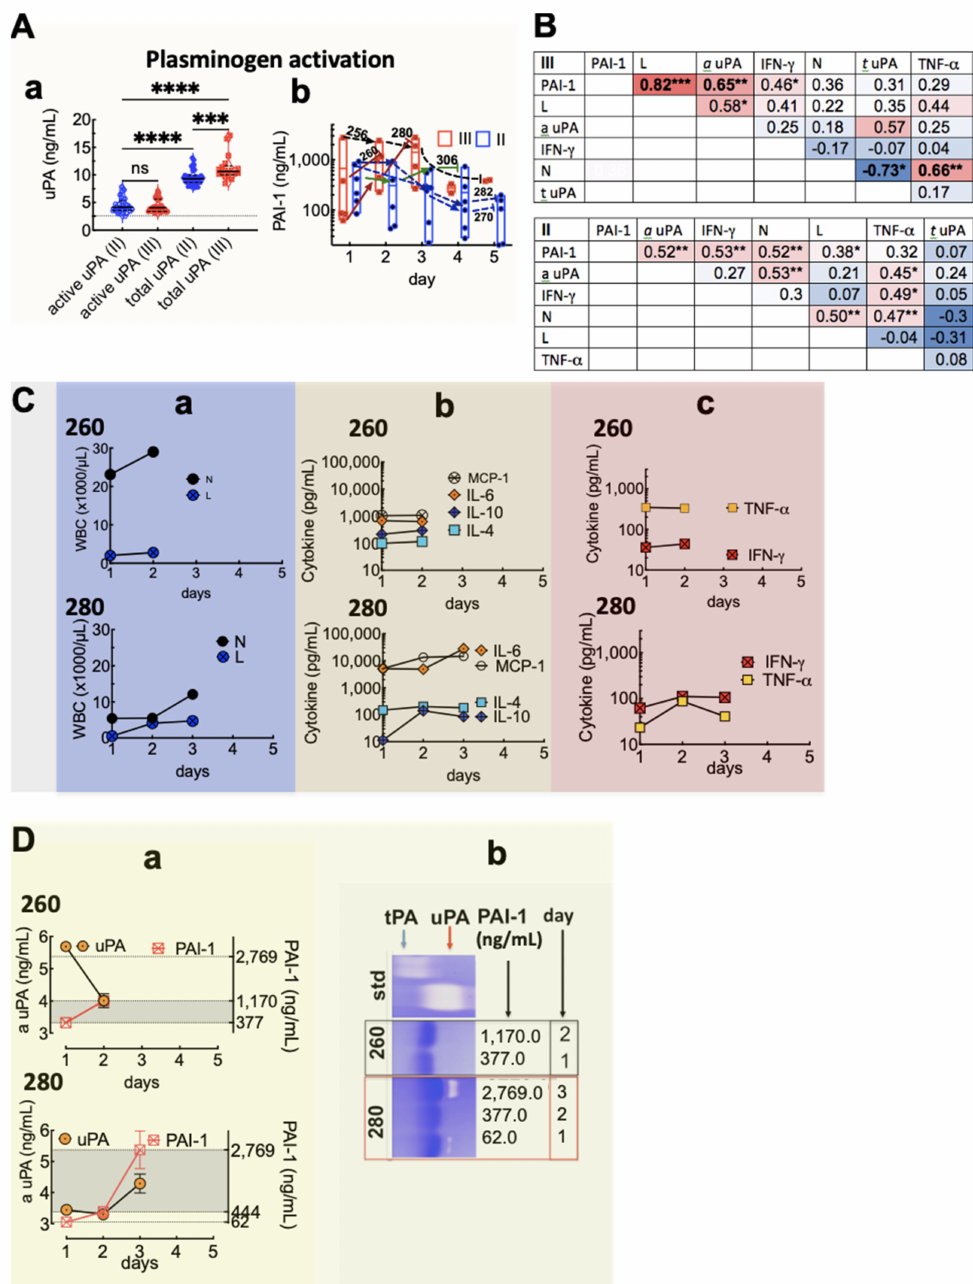
Figure 4. Peak plasma levels of uPA and PAI-1 are linked to lymphocyte expansion and IFN- γ expression. ( A ) Plasminogen activation. ( a ) Data plots of active and total uPA for Class II and III cases. Data were measured for up to 5 days for each case depending on sample availability; see Figure S1 for changes over time. ( b ) Longitudinal data plot of active PAI-1 expression for Class II and III cases. ( B ) Pearson’s correlation matrices compared PAI-1, active uPA (a uPA), total uPA (t uPA), lymphocytes (L), neutrophils (N), and IFN- γ measured in Class III and II patients. Correlations are classified according to the following scale: 0–0.19 very weak, 0.2–0.39 weak, 0.4–0.59 moderate, 0.6–0.79 strong, 0.8–1.0 very strong. Levels of active uPA and total uPA were compared by ordinary one-way ANOVA with Tukey’s correction for multiple comparison tests; * p < 0.05, ** p < 0.01, *** p < 0.001, **** p < 0.0001 ( C ) Neutrophilic- (Class III patient 260) and lymphocytosis (Class III patient 280) mediated immune response drives differential plasminogen activation responses. ( a ) Comparison of N and L expression for 260 and 280. ( b ). Expression of IL-4, IL-10, IL-6, and MCP-1. ( c ) Expression of type 1 effector cytokines. ( D ) ( a ) ELISA measurement of a uPA and PAI-1. ( b ). Zymography measurement of tPA, uPA, and ELISA measurement of